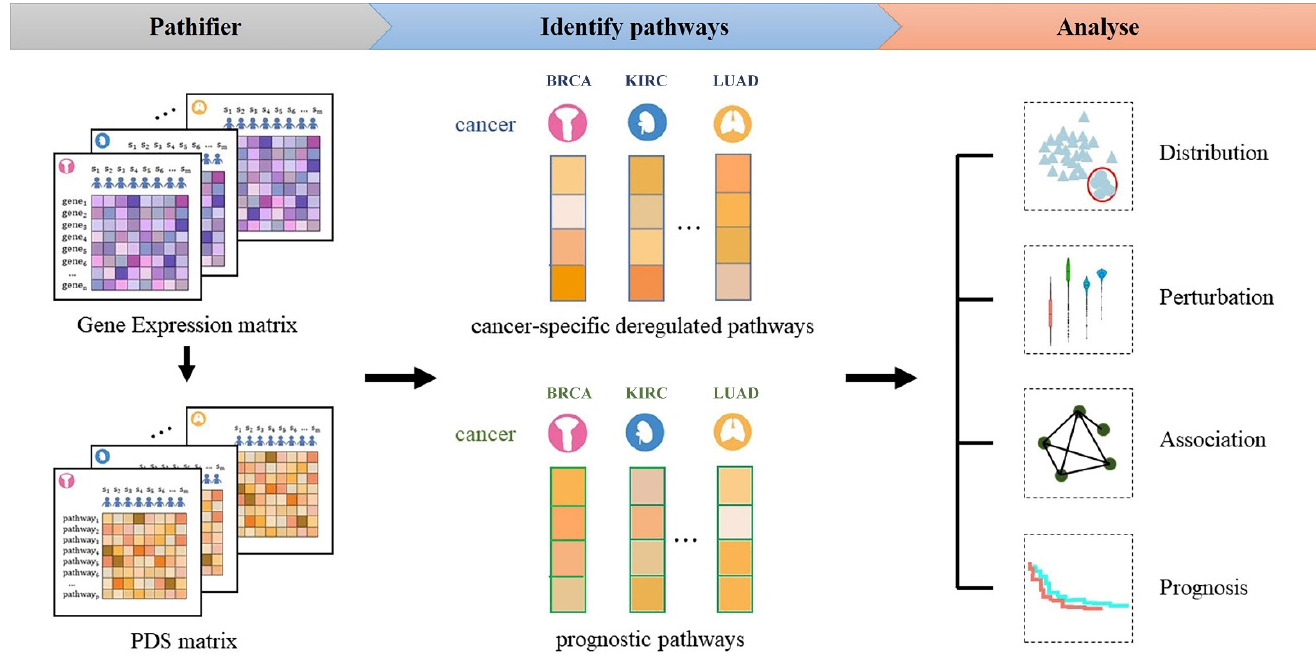
Figure 1. Flowchart of the approach.